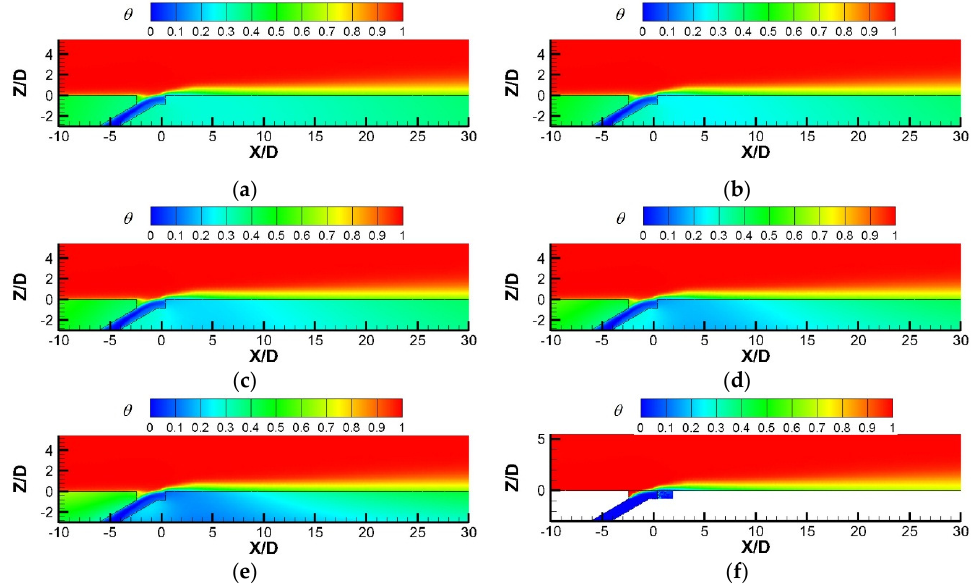
Figure 13. Non-dimensional temperature distribution over the surface Y / D = 0 at M = 1.5. ( a ) Bi = 0.026; ( b ) Bi = 0.065; ( c ) Bi = 0.13; ( d ) Bi = 0.26; ( e ) Bi = 0.65; ( f ) adiabatic.